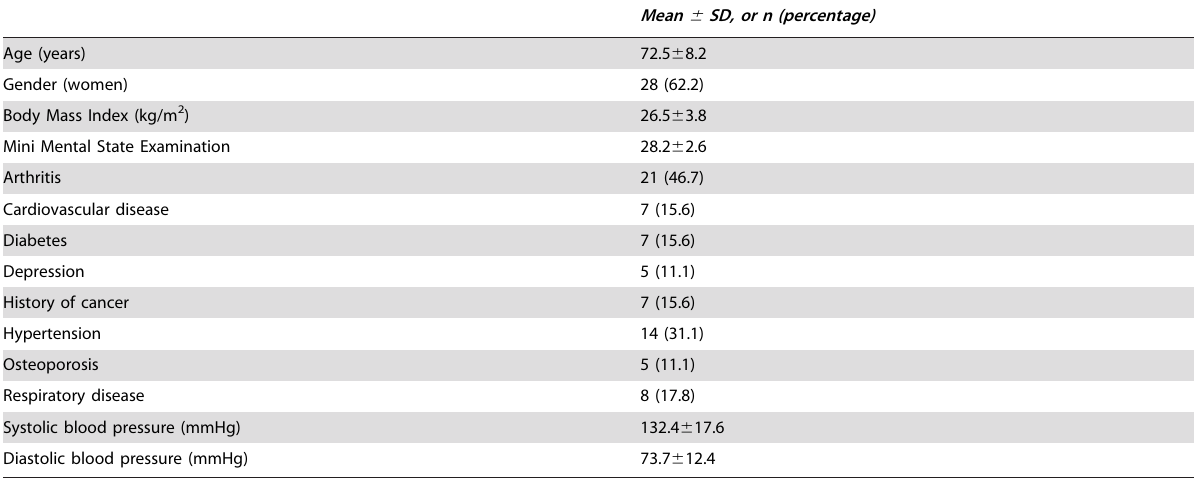
Table 2. Characteristics of the study sample (n=